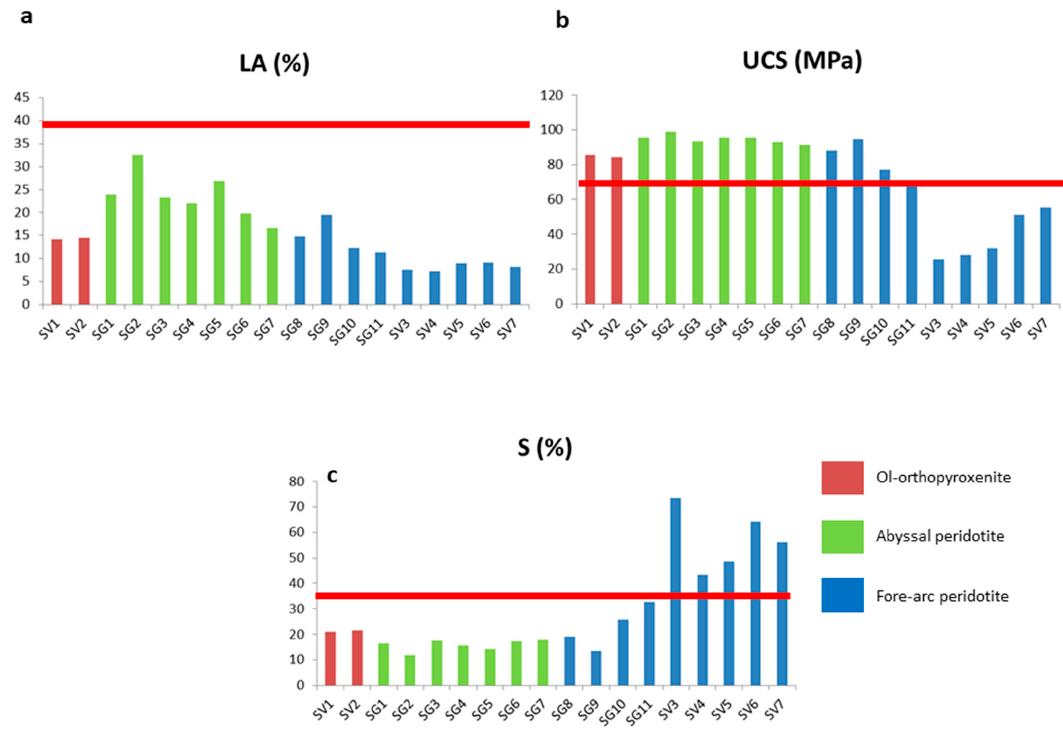
Figure 11. Diagrams of the suitability of ultramafic rock samples from the Veria–Naousa and Gerania ophiolite complexes for ( a ) the LA(%) test; ( b ) the UCS (MPa) test; ( c ) the S (%) test.